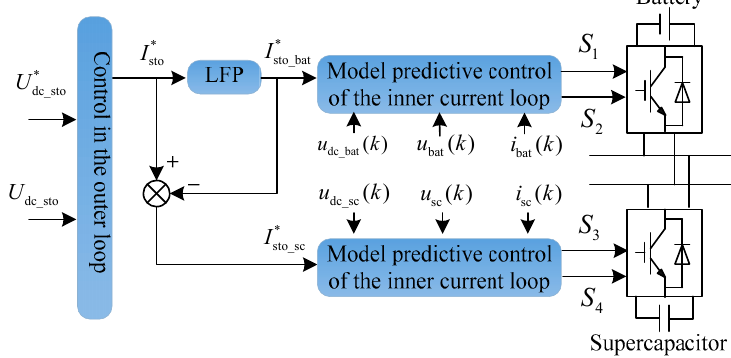
Figure 7. Control block diagram of the hybrid energy storage system.